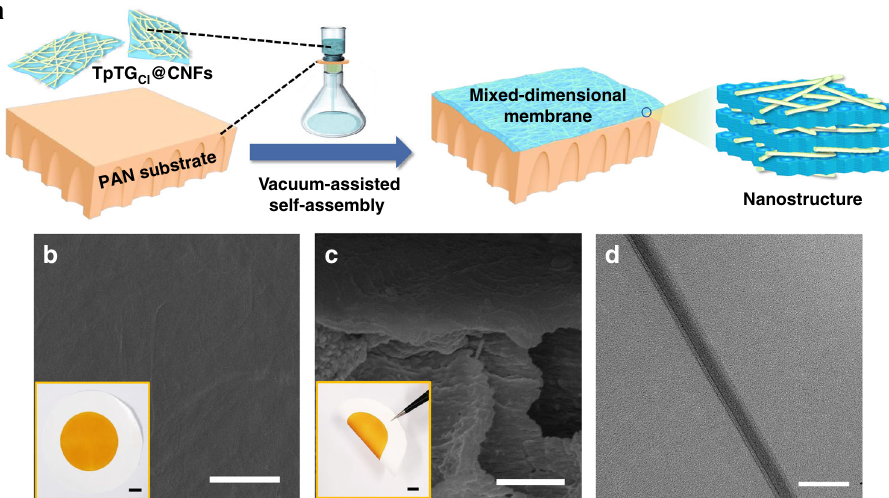
Fig. 2 Morphology of the membranes. a A schematic illustration showing the vacuum-assisted self-assembly and the mixed-dimensional nanostructure. b Surface SEM image of the TpTG Cl @CNFs-5/PAN membrane (scale bar, 1 μ m) inserted with a digital photo of the membrane (scale bar, 1 cm). c Cross- sectional SEM image of the TpTG Cl @CNFs-5/PAN membrane (scale bar, 1 μ m) inserted a tweezer bent membrane photo (scale bar, 1 cm). d Cross- sectional TEM image of the TpTG Cl @CNFs-5 membrane (scale bar, 50 nm)